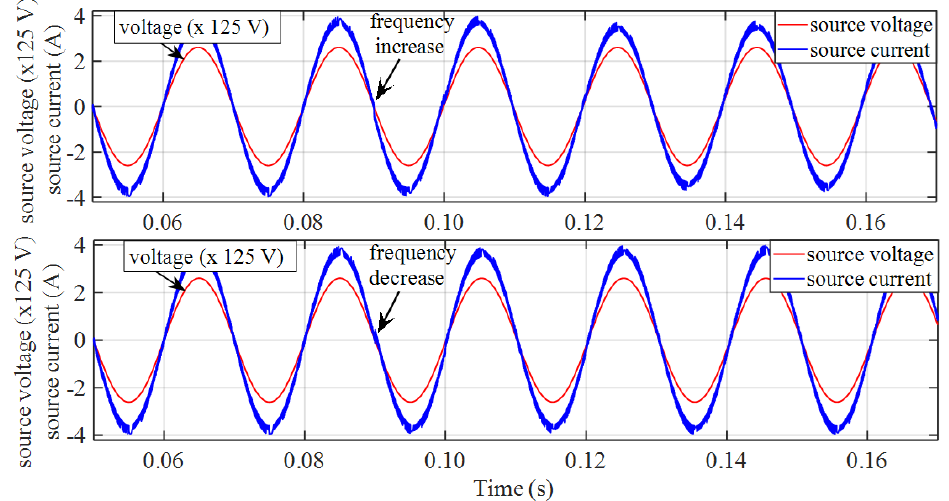
Figure 13. Dynamic response with frequency changes, showing the source current and voltage waveforms. Top graph: change from 50 to 50.5 Hz at t = 0.09 s. Bottom graph: change from 50 to 49.5 Hz at t = 0.09 s.